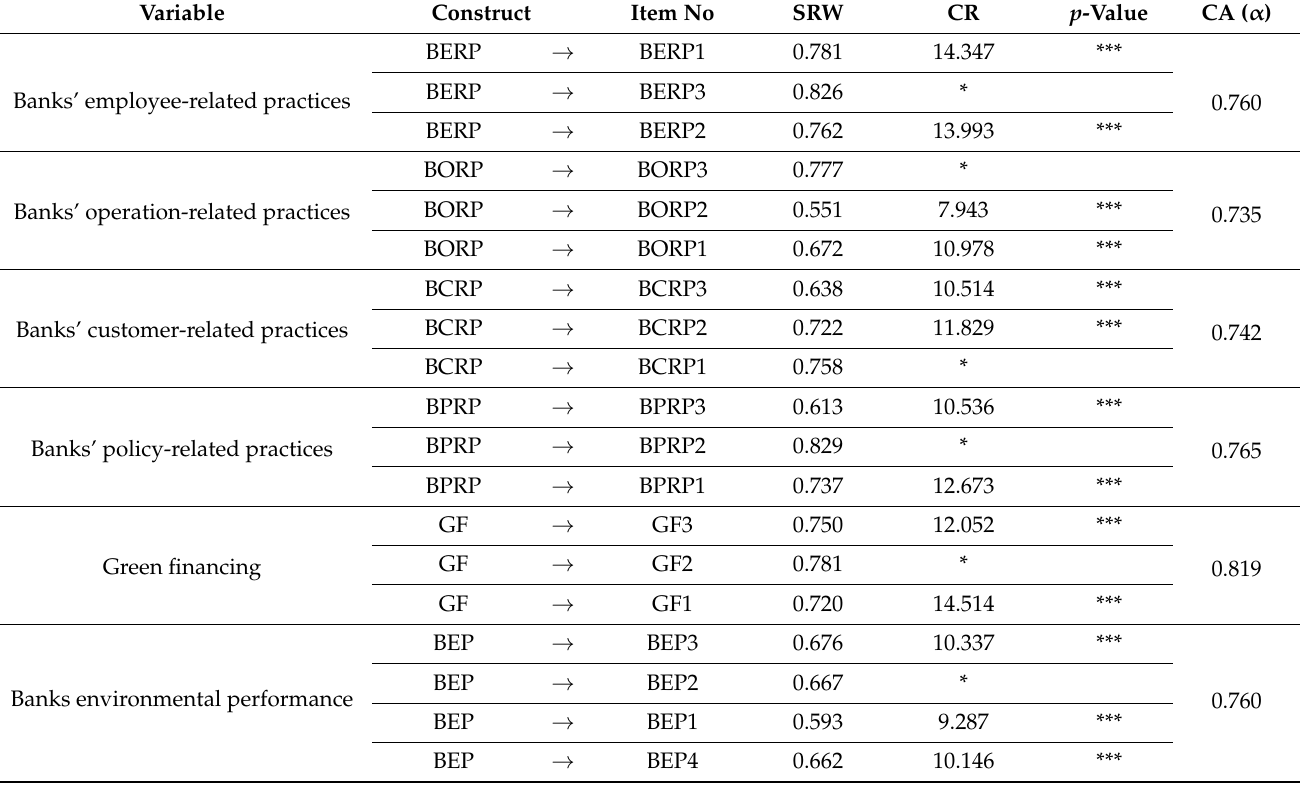
Table 7. Model Estimates and